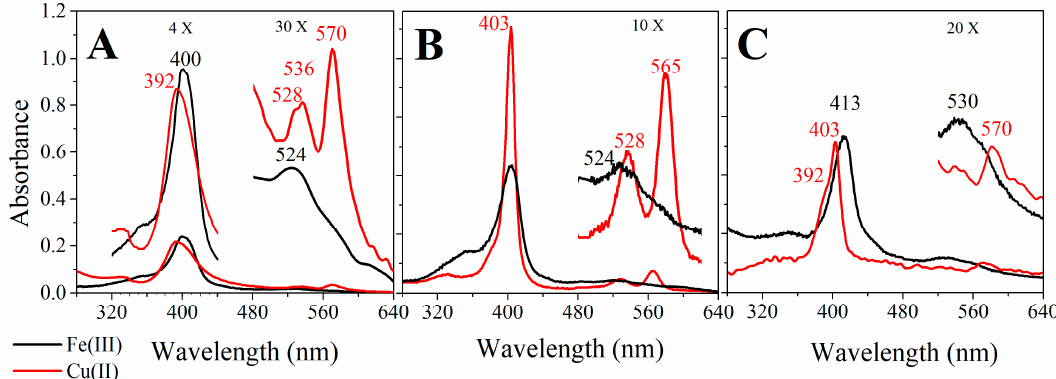
Figure 3. Comparative UV-visible spectra of Fe(III) or Cu(II)MP-11 in homogeneous and heterogeneous media. ( A ) The homogeneous medium is 5 mM HEPES buffer at pH 7.4. The heterogeneous medium is a suspension of ( B ) HEPES buffered 20 mM CTAB micelles and ( C ) HEPES buffered 2 mM DODAB LUVs. The spectra of 20 µM Fe(III) (black line) and Cu(II) (red line) MP-11 were recorded using a 0.1 cm quartz cuvette at 25 °C. For the systems with low colloidal stability, a 30 min of heating preceded the spectral analysis. The principal λ max values are indicated in the